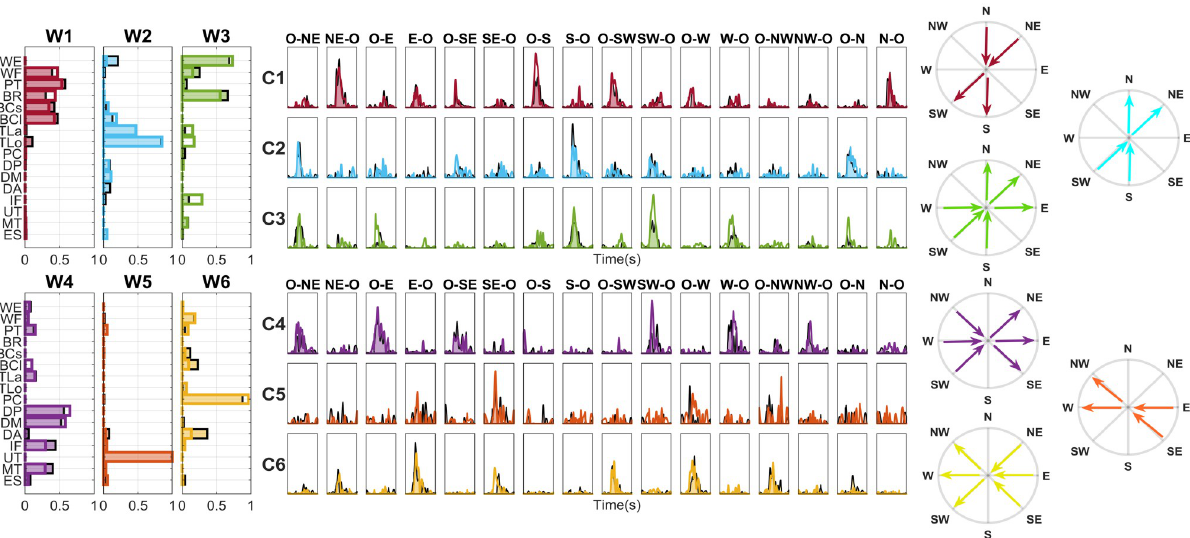
Fig 13. For a typical subject, comparison between spatial synergies, temporal coefficients, and directional tuning. On the left, the spatial synergies of the two modes are represented overlapped (Free data have a black edge and a colored light area; Assisted data have a marked colored edge and an empty area). In the center of the Figure, the temporal coefficients of the MS are portrayed, with the same colorcode used for spatial synergies. On the right, the directional tuning of spatial synergies is portrayed.